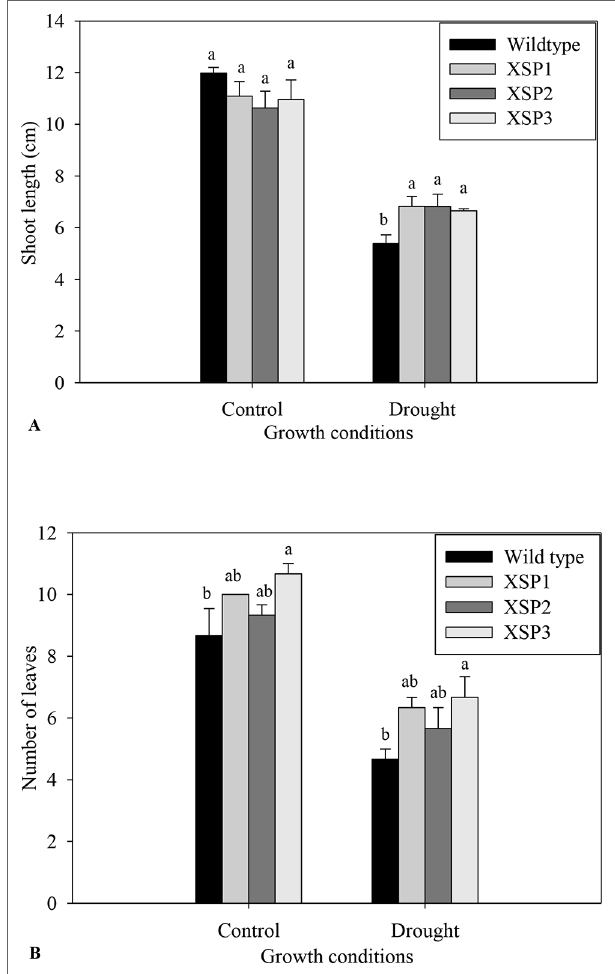
FIGURE 3 | Phenotypic index changes of wild-type and XvSap1 transgenic sweet potato plants under control and drought stress conditions. (A) Shoot length. (B) Number of leaves. Means ± SE (standard error) followed by different alphabets in each growth condition are significantly different ( P ≤ 0.05 ) using Fisher’s least significant difference (LSD). Data are from three independent replicates of the same event. ( Table S5 and Table S6